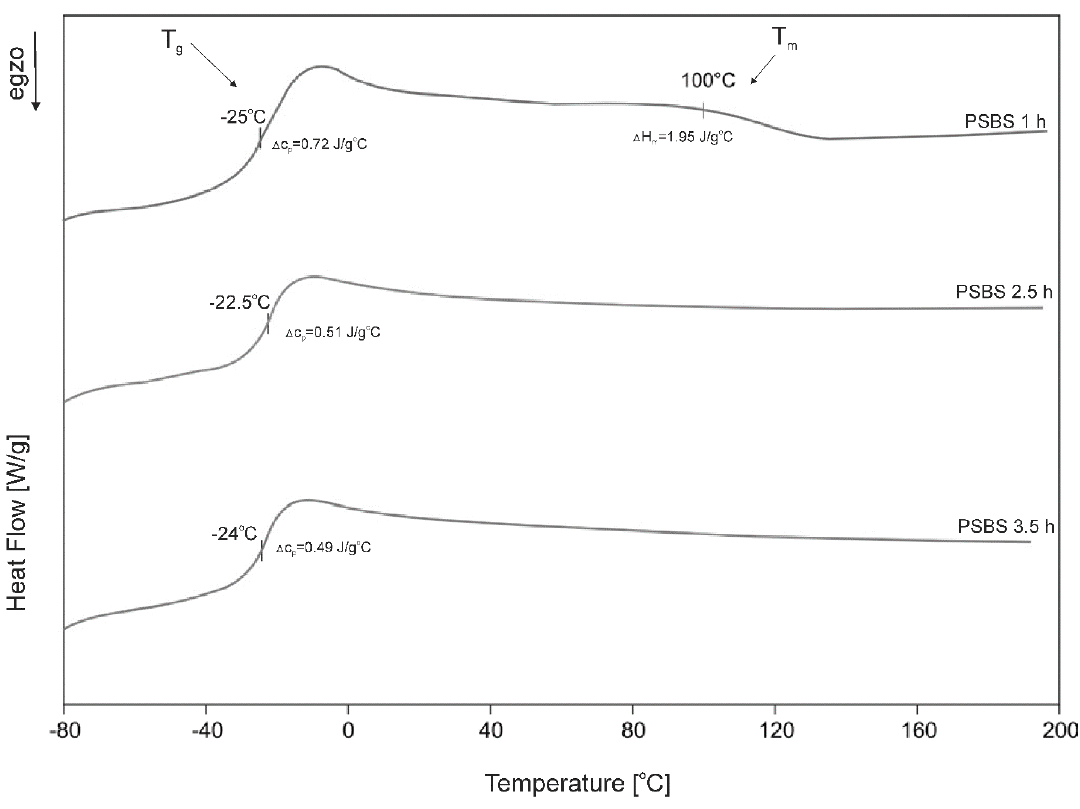
Figure 3. First-heating differential scanning calorimetry (DSC) thermograms of PSBS 1 h, PSBS 2.5 h and PSBS 3.5 h.